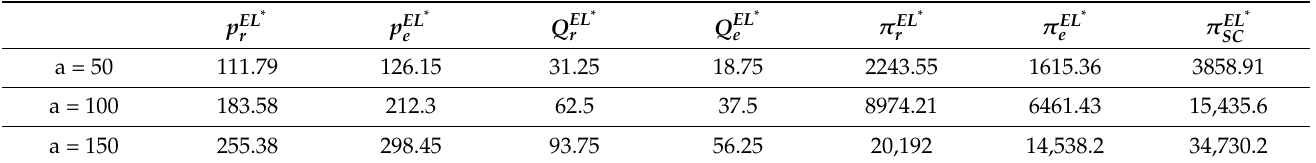
Table 3. Optimal decisions of channel members under the EL game—Case